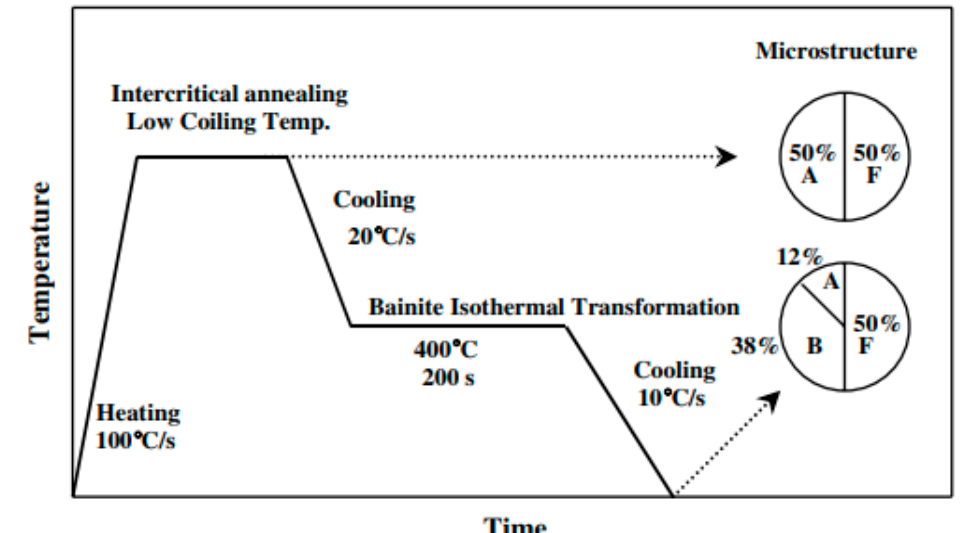
Figure 6. Heat treatment process of TRIP steel: the inter-critical annealing and isothermal transformation processes. A is austenite, F is ferrite, B is Bainite. Reprinted from [48], with permission of Elsevier, 2006.